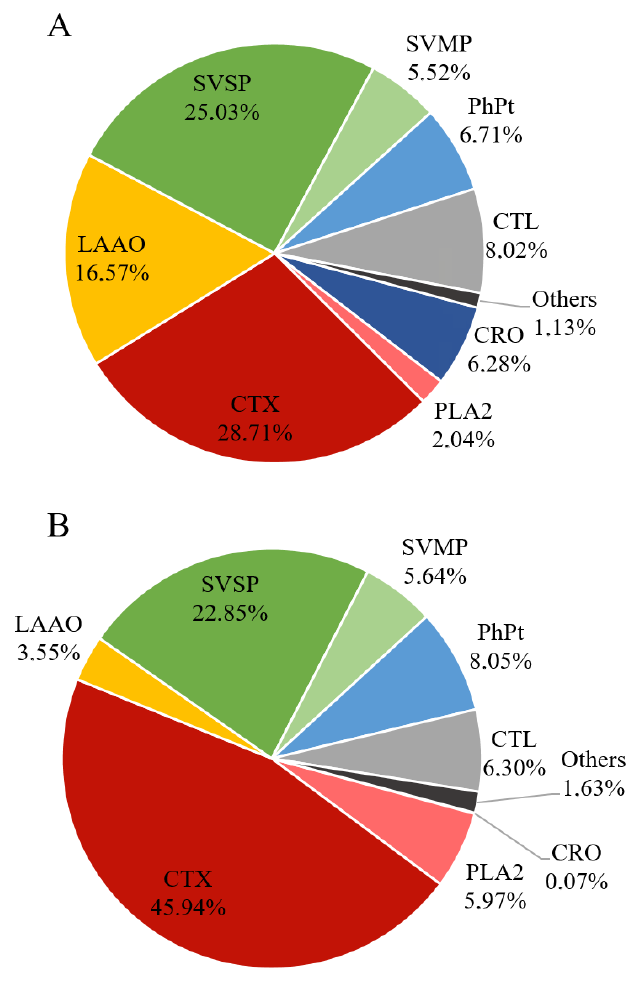
Figure 7. Overall composition estimated by mass spectrometry of venom pools from C. durissus according to protein families, expressed as percentages. (A) Crotamine-positive venom pool, (B) crotamine-negative venom pool. : phospholipase A ; CTX: Protein family abbreviation – CRO: crotamine; PLA 2 2 crotoxin; LAAO: L-amino acid oxidase; SVSP: snake venom serine protease; SVMP: snake venom metalloproteinase; PhPt: phosphoprotein; CTL: C-type lectin. Others – globin: fragment of globin HBD, BPP: bradykinin potentiating peptide, PLI: phospholipase A inhibitor; VNGF: venom nerve growth 2